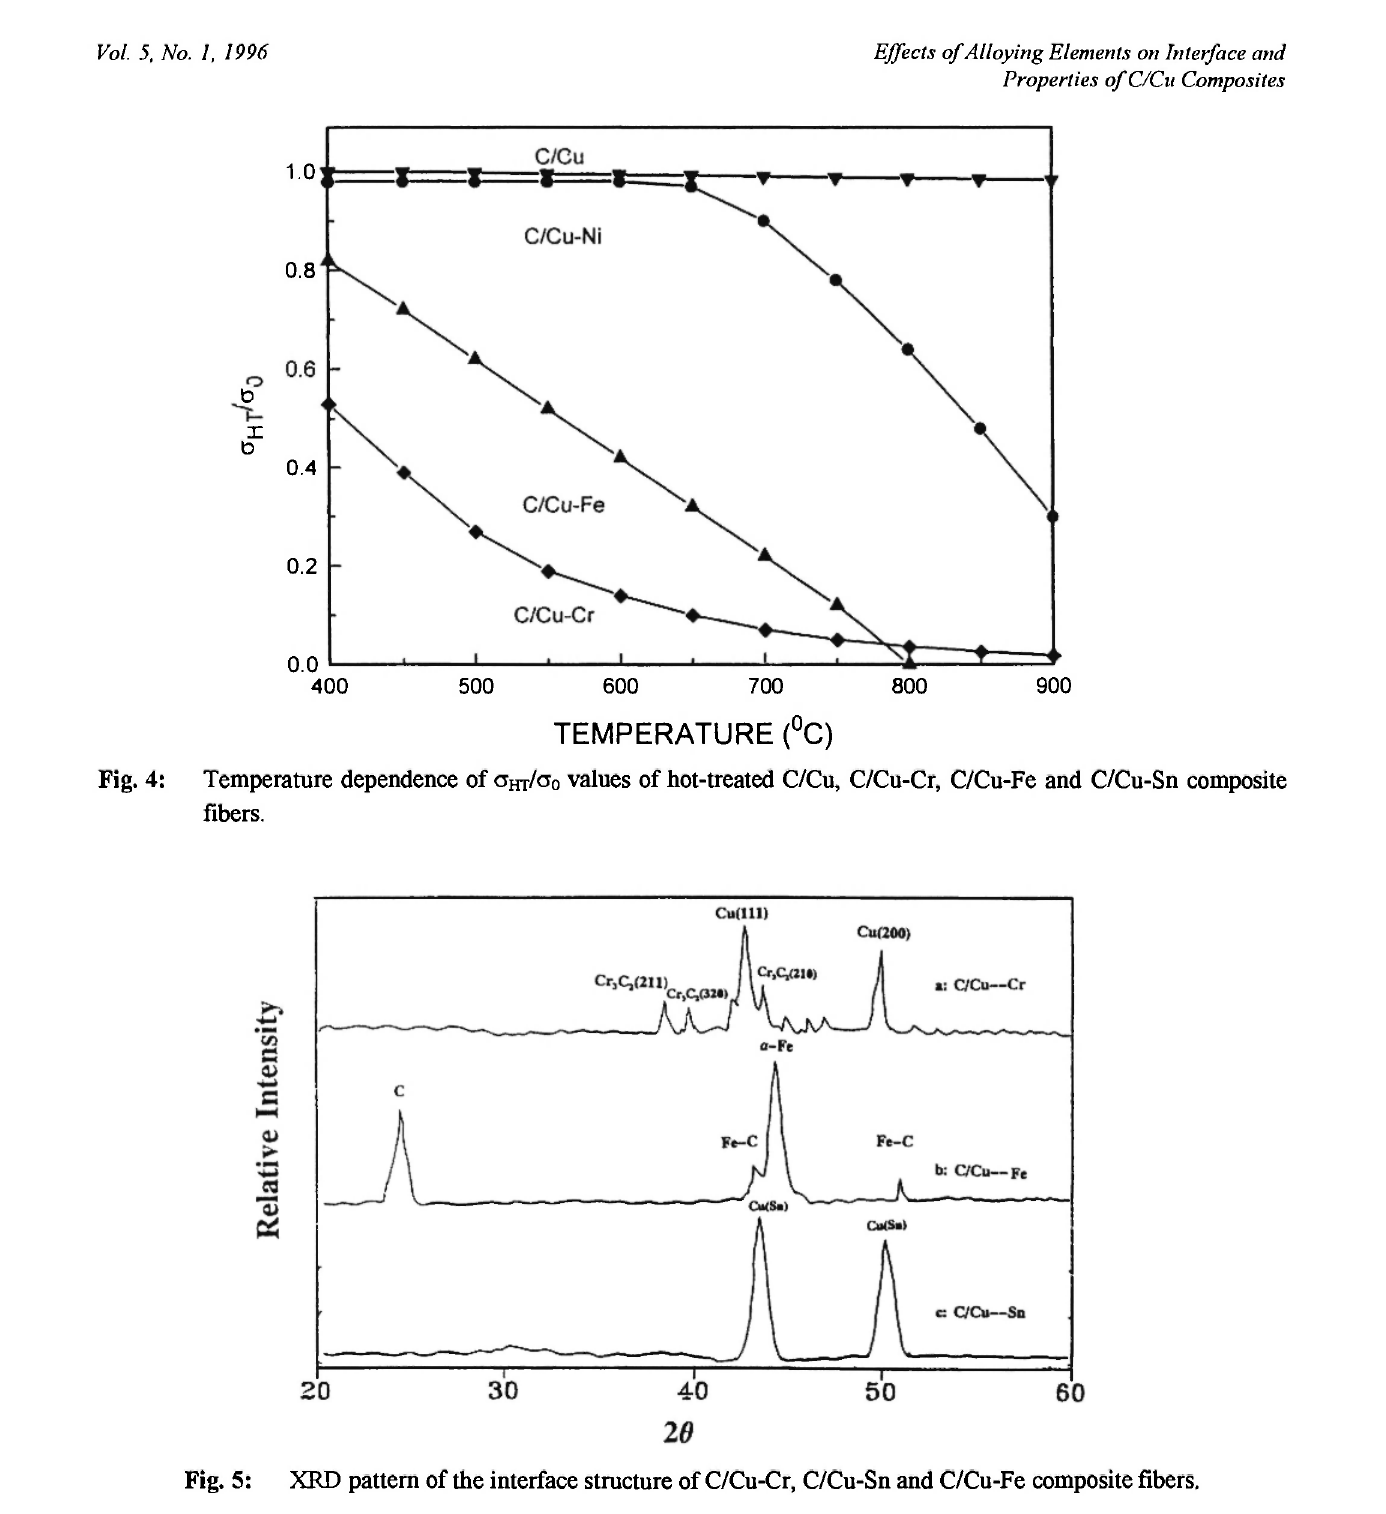
Fig. 5: XRD pattern of the interface structure of C/Cu-Cr, C/Cu-Sn and C/Cu-Fe composite fibers. carbon and Cr and Fe. By depositing a very thin layer there was chemical reaction between carbon fiber and of copper first and then Cr and Fe layers, a diffusion Cr or Fe in the interface region. Another effect that was barrier which can reduce the Cr-C and Fe-C interaction observed in experiments was the strength degradation was developed. As far as the degrees of of carbon fibers induced by the alloy effects between